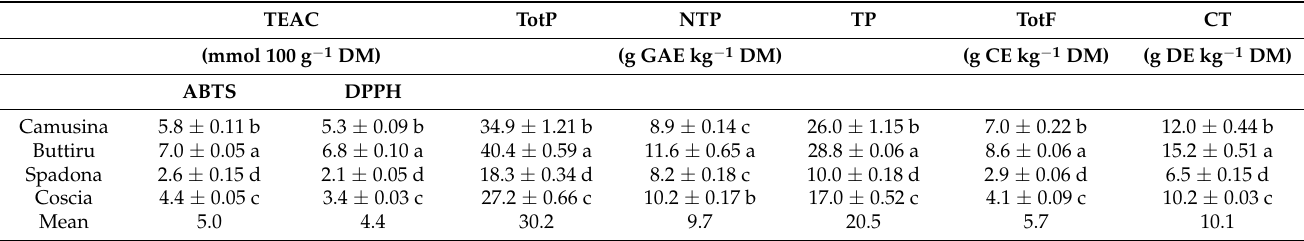
Table 3. Total antioxidant capacity (TEAC) by ABTS and DPPH methods, total phenolics (TotP), non-tannic phenolics (NTP), tannic phenolics (TP), total flavonoids (TotF), and condensed tannins